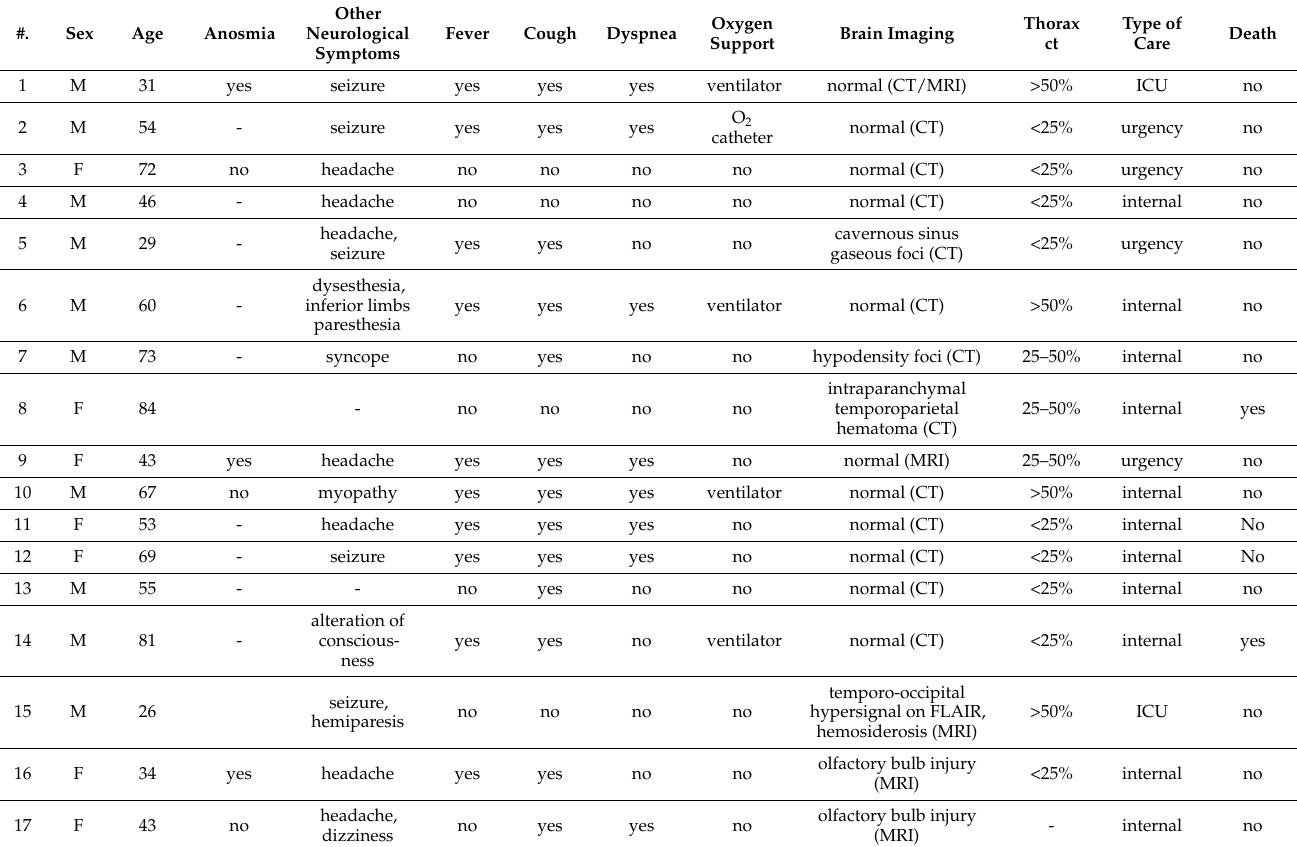
Table 2. Characteristics of COVID-19 patients undergoing brain imaging